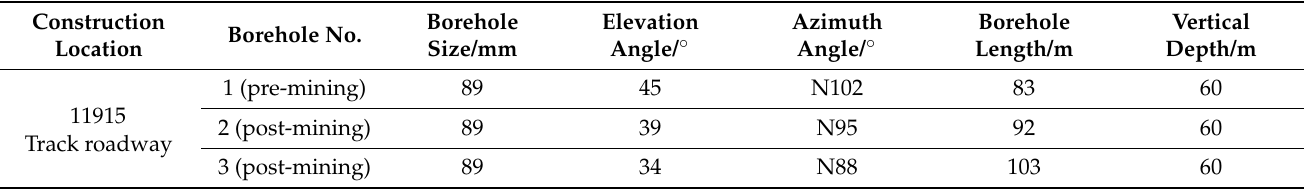
Table 4. Borehole construction